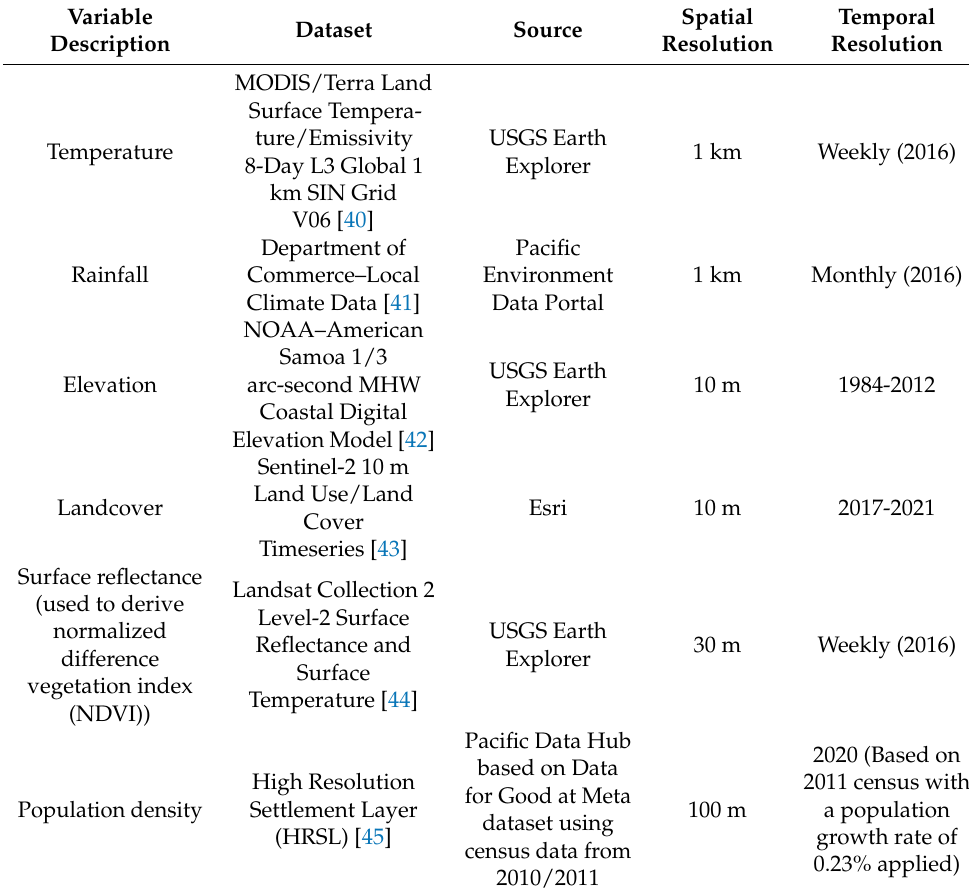
Table 1. Datasets and sources for each environmental variable included in this study, with details of their spatial and temporal resolutions, American